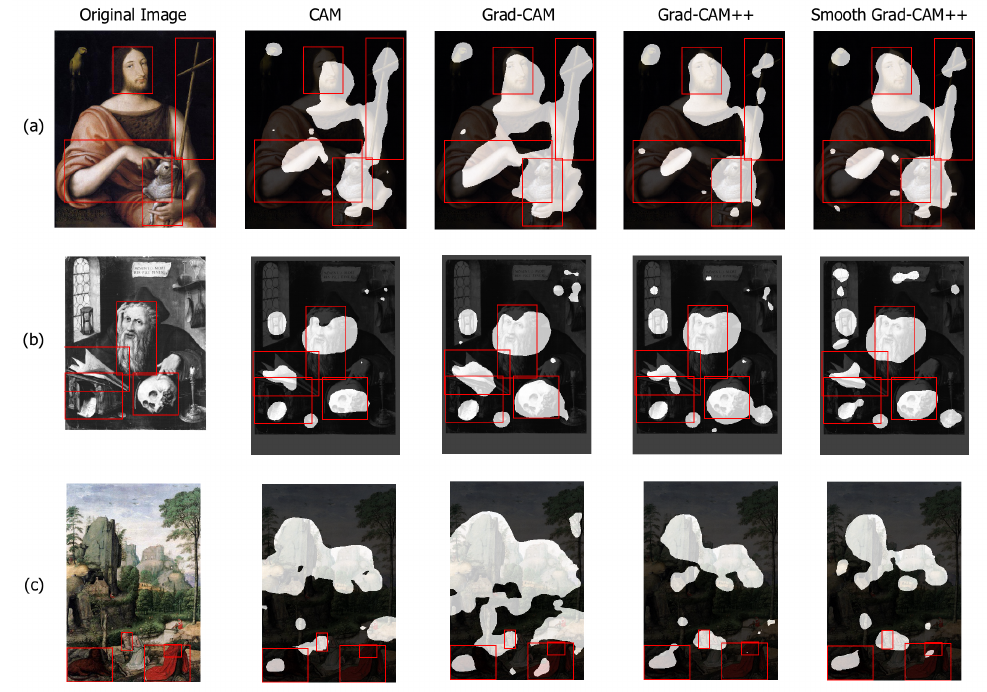
Figure 17. Class activation maps highlighting regions containing relevant iconographic attributes not present in the ground truth: a bird associated with Saint John the Baptist ( a ) an hourglass associated with Saint Jerome ( b ) and the wilderness where Saint Jerome retired ( c ).